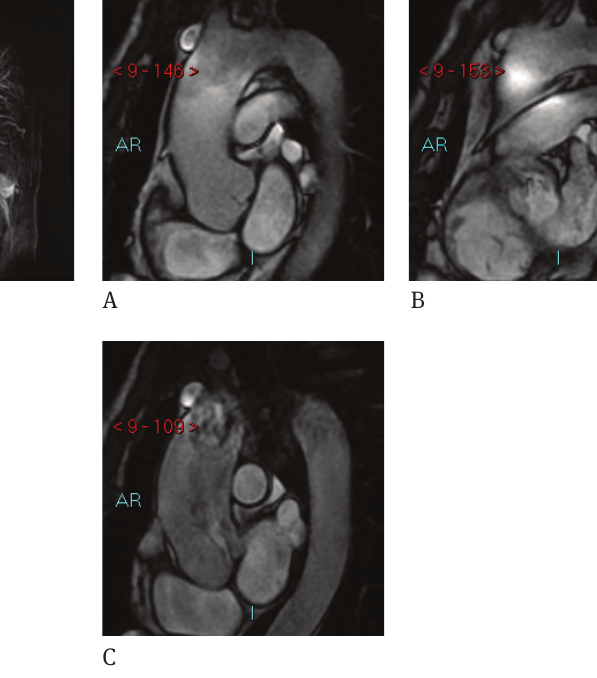
Figure 5: PR-TRIKS sequences are able to evaluate the progression of the contrast media at the pulmonary arteries (A), at the proximal aorta (B) and at the distal aorta (C).